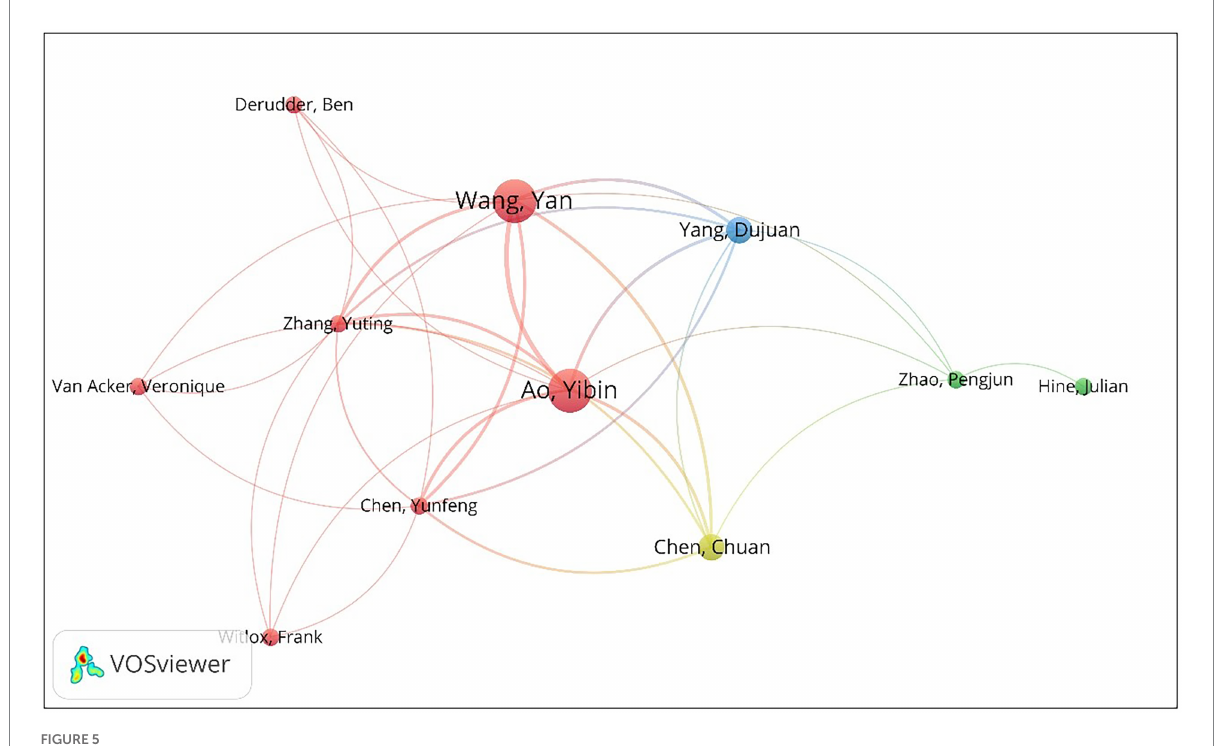
FIGURE 5 Map of co-authorship in the field of rural travel